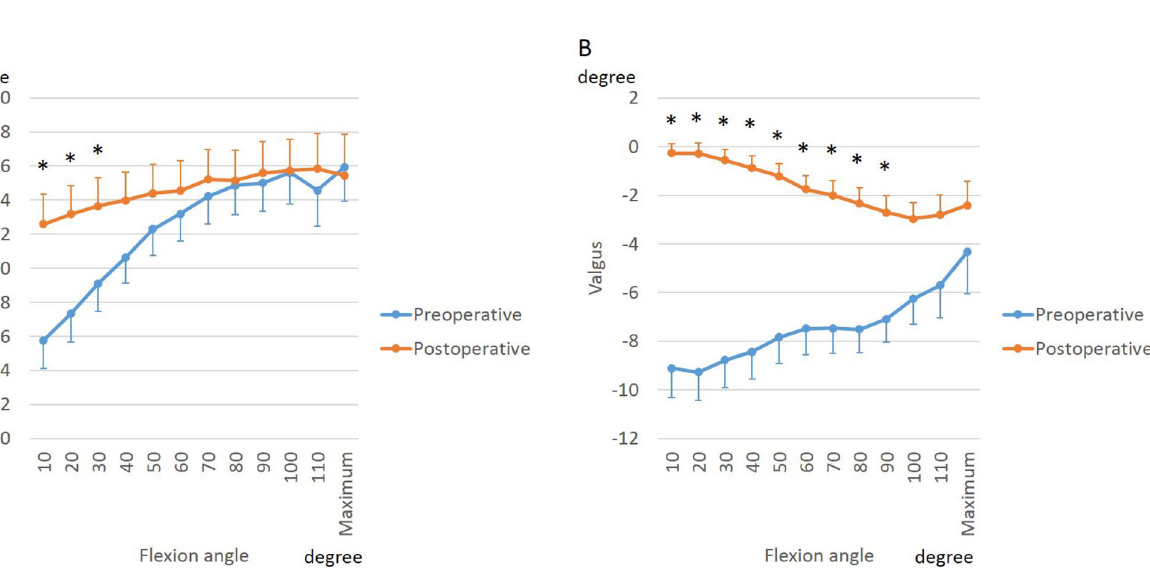
Figure 1. Effect of BCR-TKA on knee kinematics: external rotation ( A ) and valgus ( B ) of femoral component relative to tibial